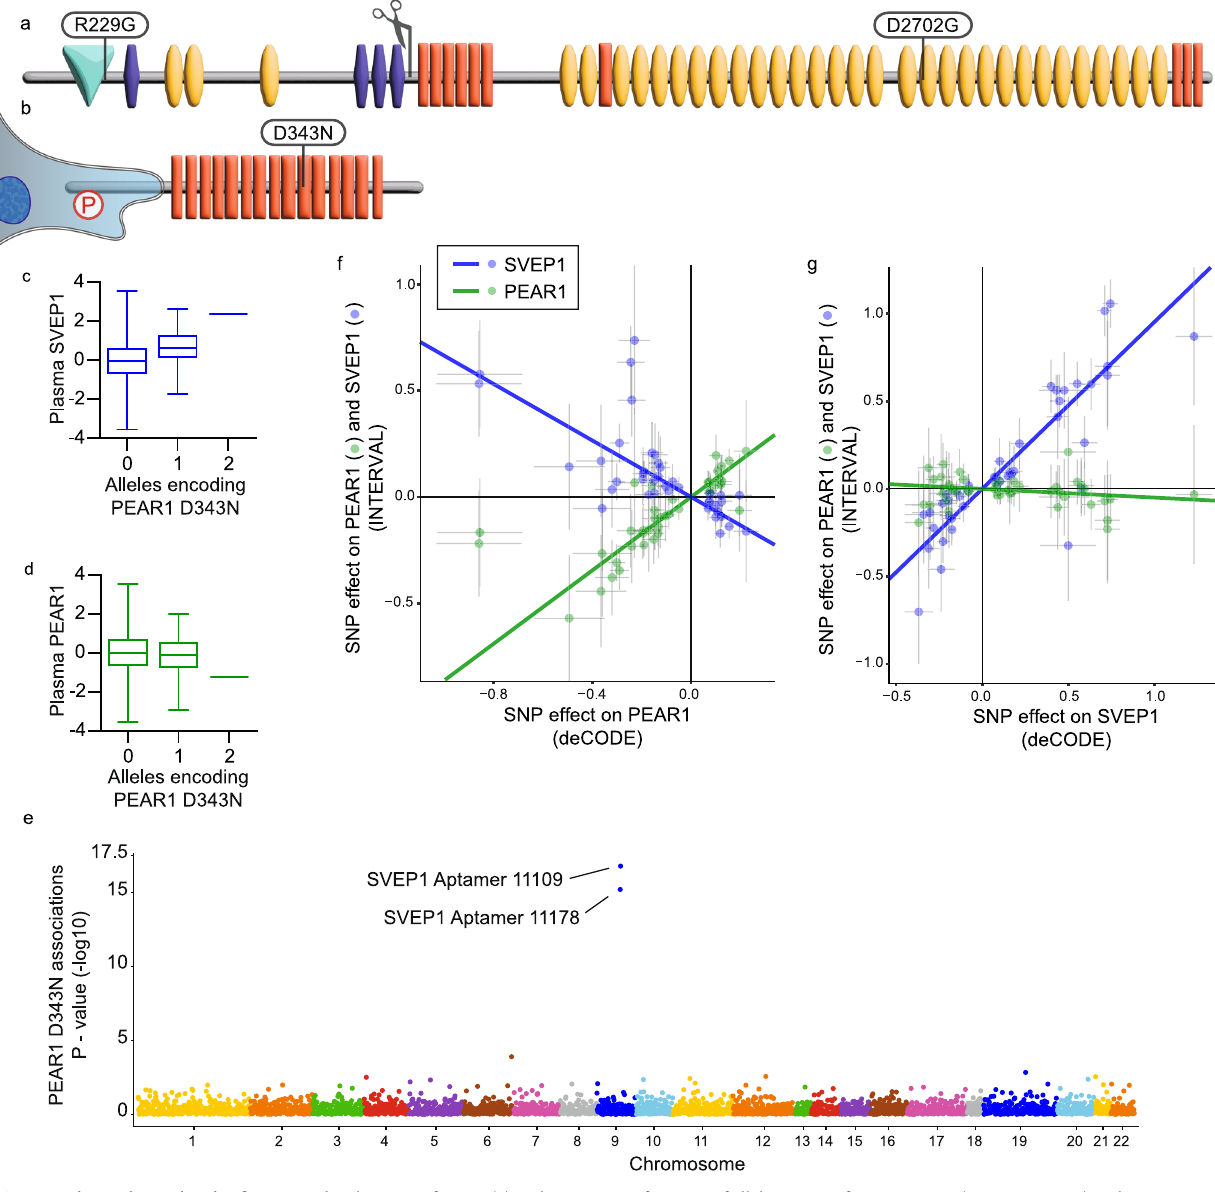
Fig.1| PEAR1 altersplasmalevelsofSVEP1.a , b SchematicofSVEP1( a )andPEAR1 ( b ) proteins. Domains were identi fi ed using the Simple Modular